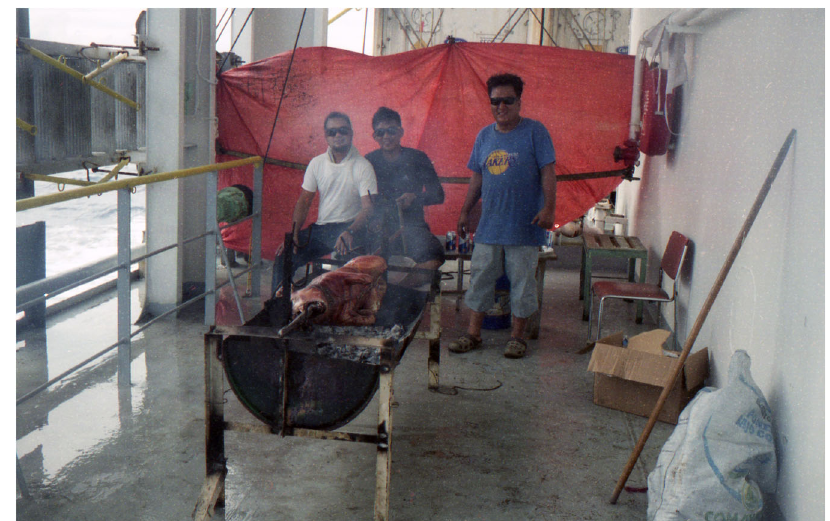
Fig. 10 Pig Roast. Photograph was taken by participant of a pig roast.